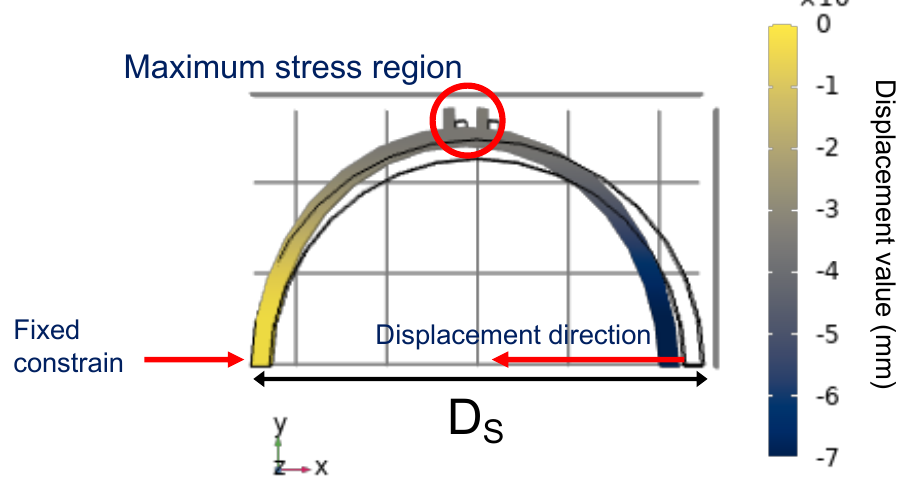
Figure 4. Static structural analysis, based on FEM, of the piece with